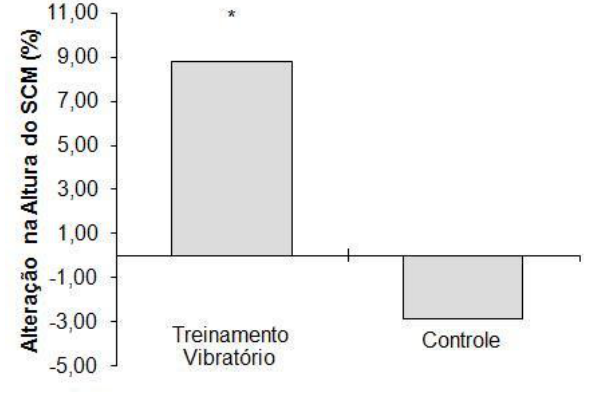
Figura 3. Alterações percentuais na altura do SCM para as condições treinamento vibratório e controle. *Diferença significativa entre os resultados de pré-teste e pós-teste